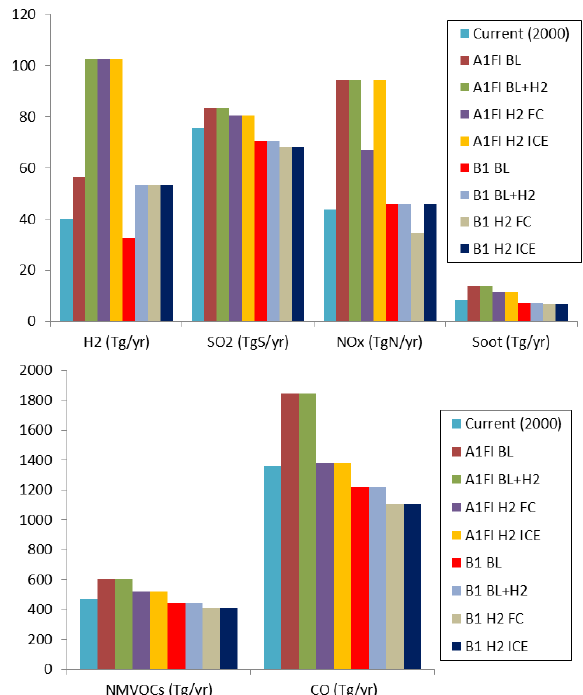
Figure 1. Global annual emissions of H 2 , SO 2 , NO x , soot, NMVOCs and CO for the current 2 Fig. 1. Global annual emissions of H 2 , SO 2 , NO x , soot, NMVOCs (year 2000), and the Baseline (BL) , Baseline+H 2 (BL+H 2 ), H 2 Fuel Cell (H 2 -FC), and H 2 3 and CO for the current (year 2000), and the 2050 A1FI and B1 scenarios: baseline (BL), baseline + H 2 (BL + H 2 ) , H 2 fuel cell Internal Combustion Engine (H 2 -ICE) 2050 A1FI and B1 scenarios. 4 (H 2 -FC), and H 2 internal combustion engine (H 2 -ICE)